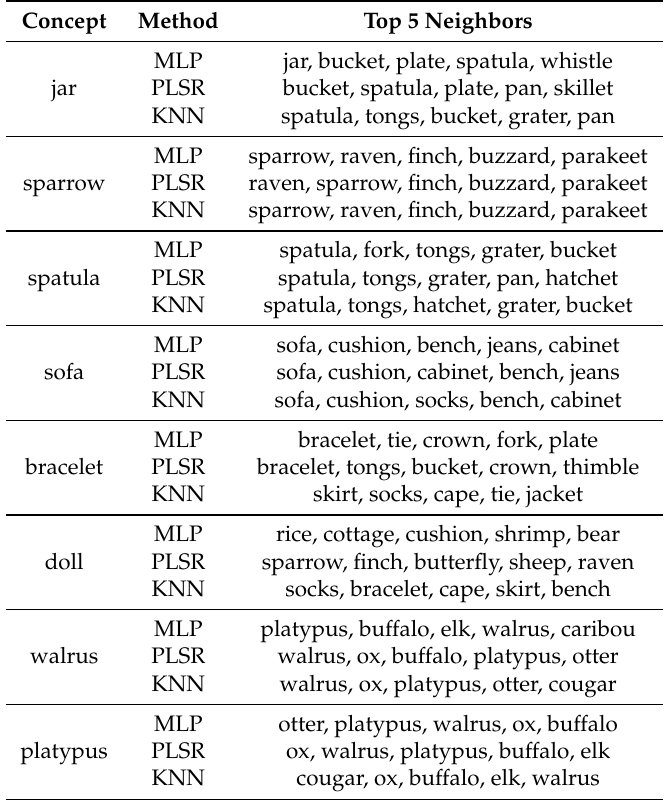
Table 7. Top 5 neighbors returned by MLP, PLSR, and